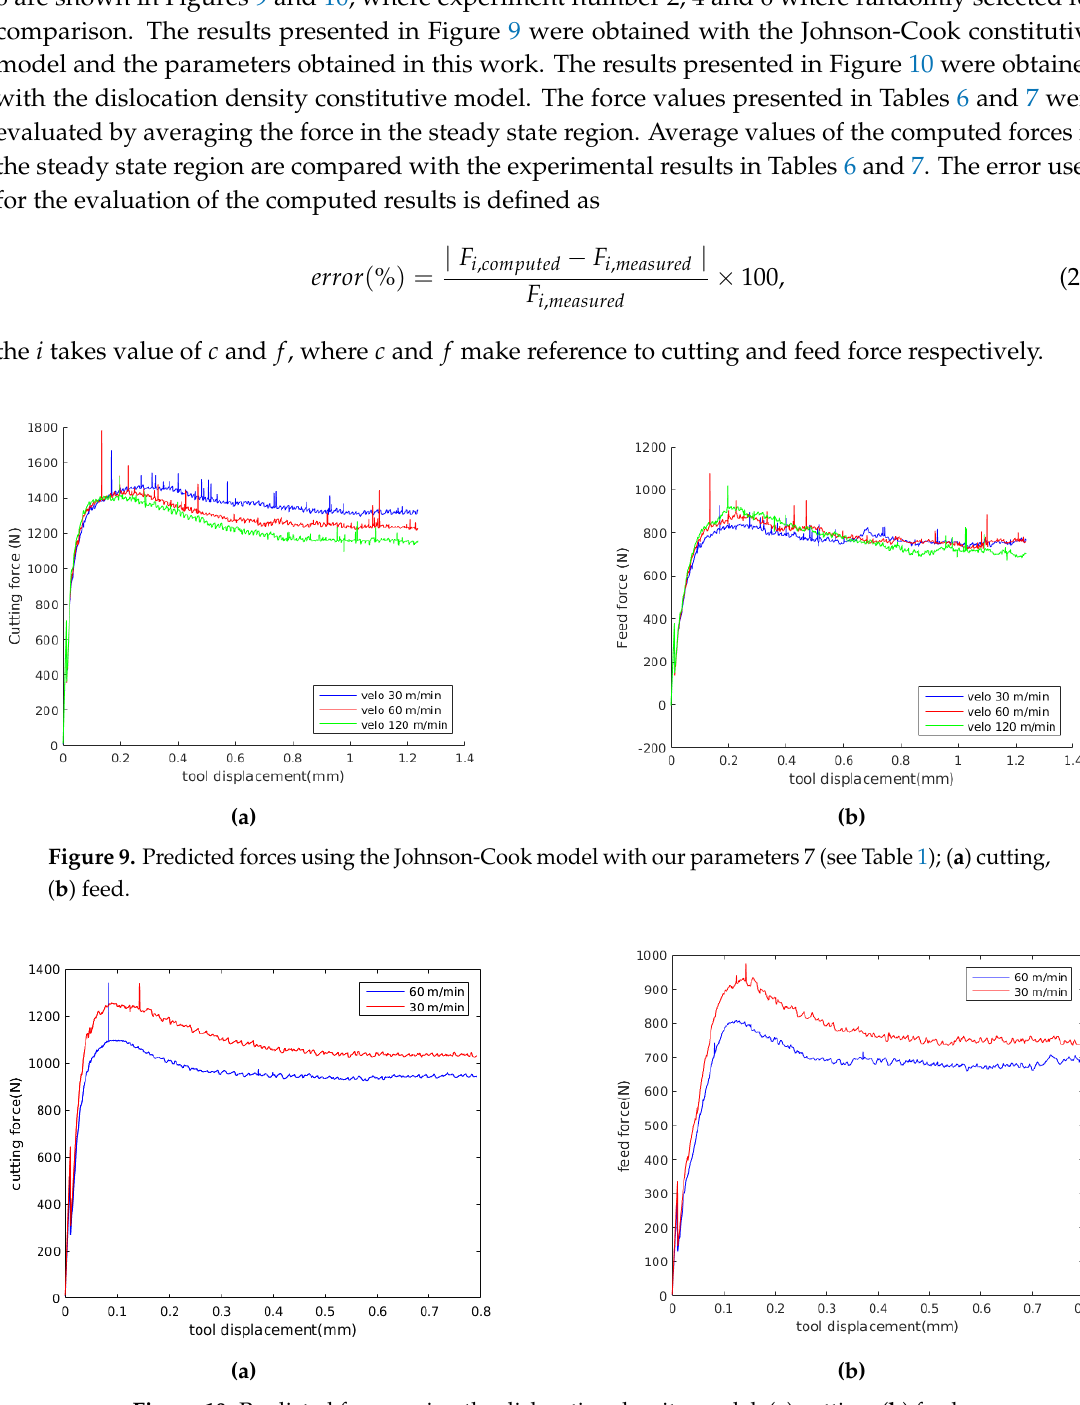
Figure 10. Predicted forces using the dislocation density model; ( a ) cutting, ( b )